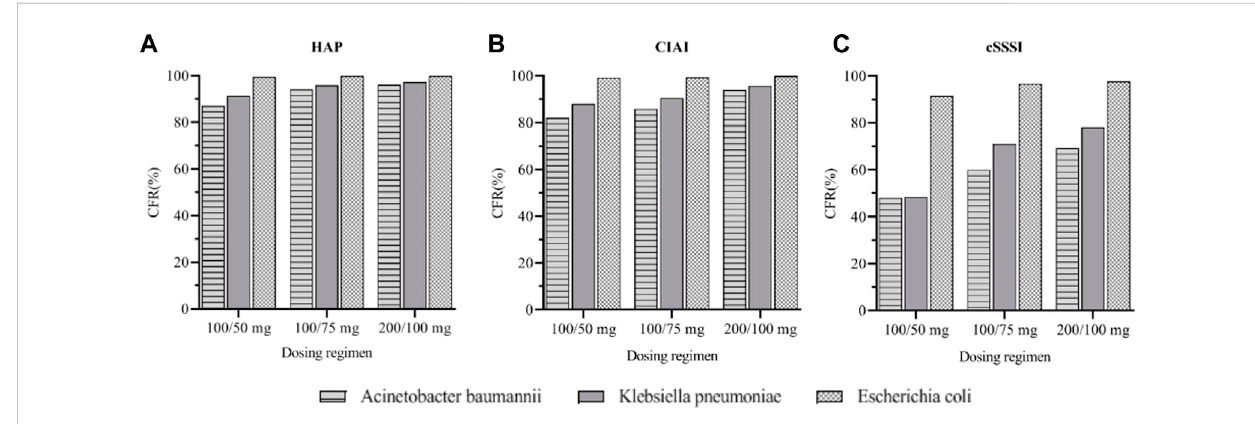
FIGURE 5 Cumulativefractionofresponse(CFR)ofthreetigecyclinedosagesregimensindifferentsitesofinfection. (A) :CFRforthreeGram-negativebacteria under different dosages regimens of HAP (B) : CFR for three Gram-negative bacteria under different dosages regimens of cIAI (C) : CFR for three Gram- negative bacteria under different dosages regimens of